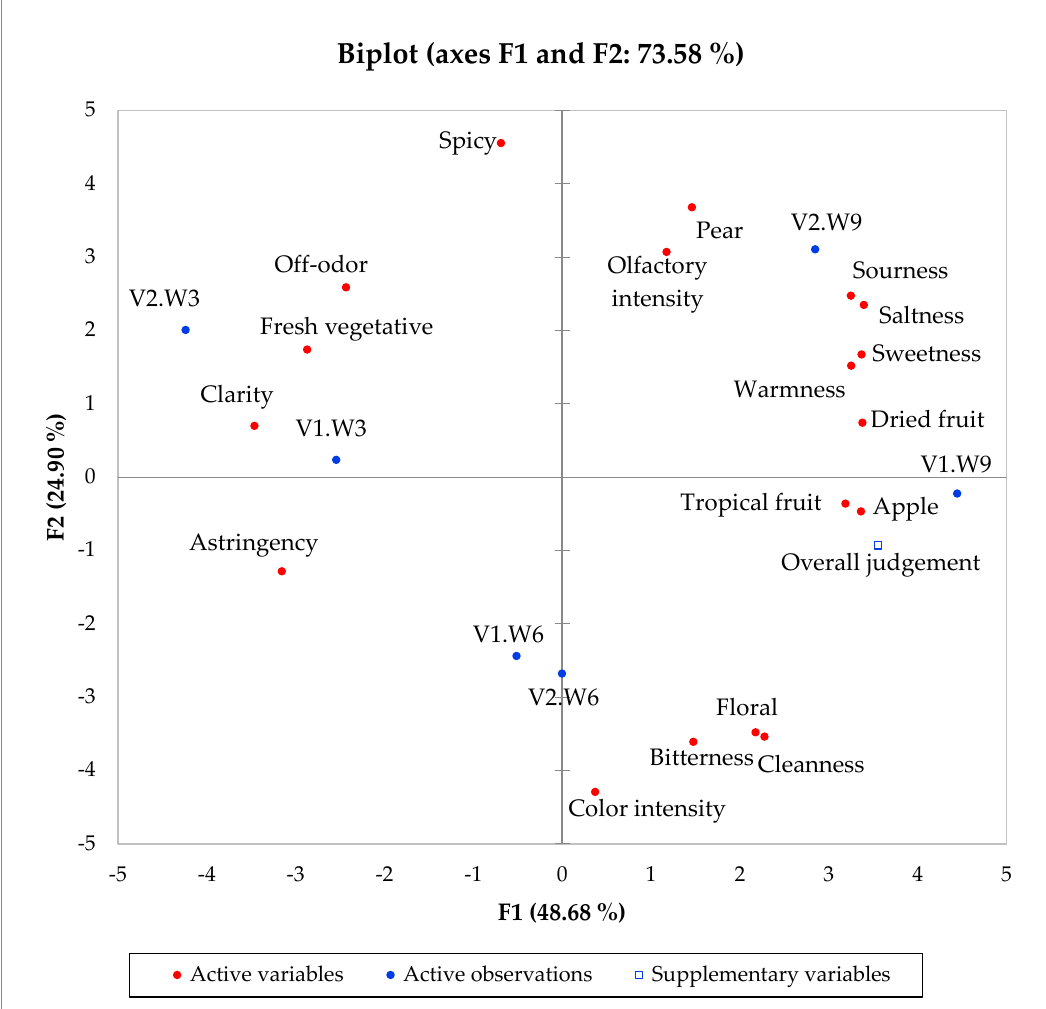
Figure 3. Principal component analysis (PCA) on sensory profile data of Pinot Blanc wines. V: vinification type